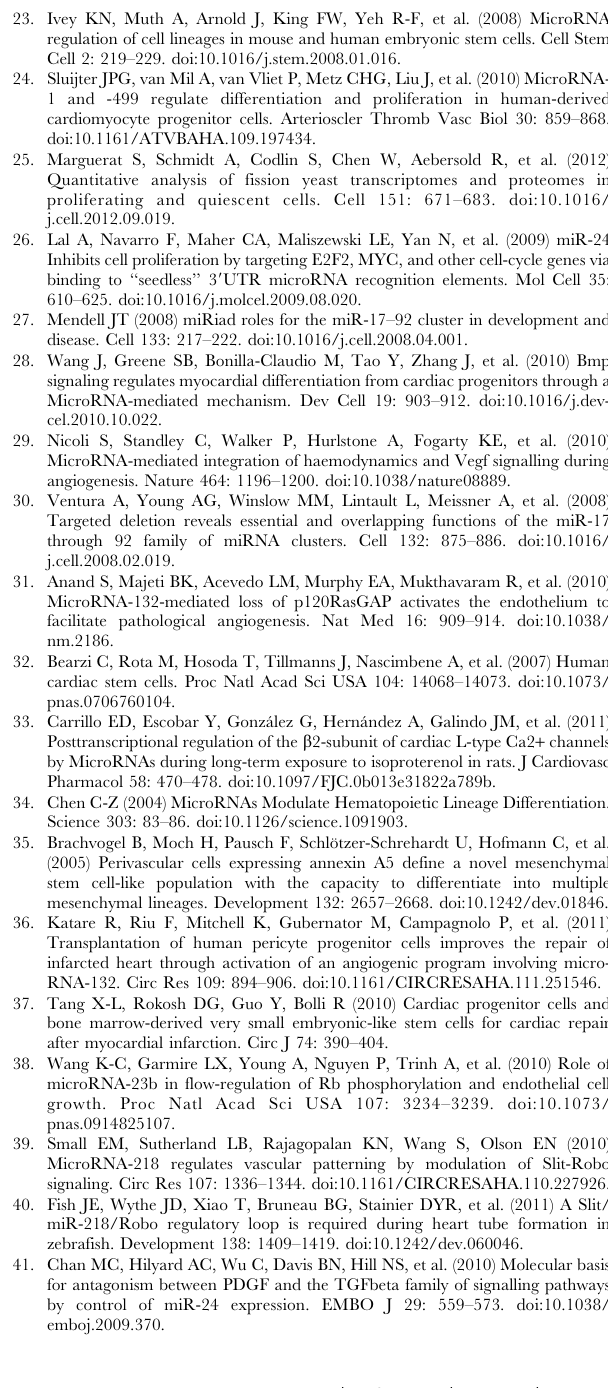
Figure S1 Fluorescence activated cell sorting of Sca-1 expressing cells isolated from adult mouse heart. An unstained sample (left plot, A) was used as negative control to define the sorting gate. Sca-1 positive cells (right plot, A) were identified based on FITC-positive signal in the 530/30 nm channel, and distinguished from negative cells with high autofluorescence using an autofluorescence channel with 585 6 20 nm range.